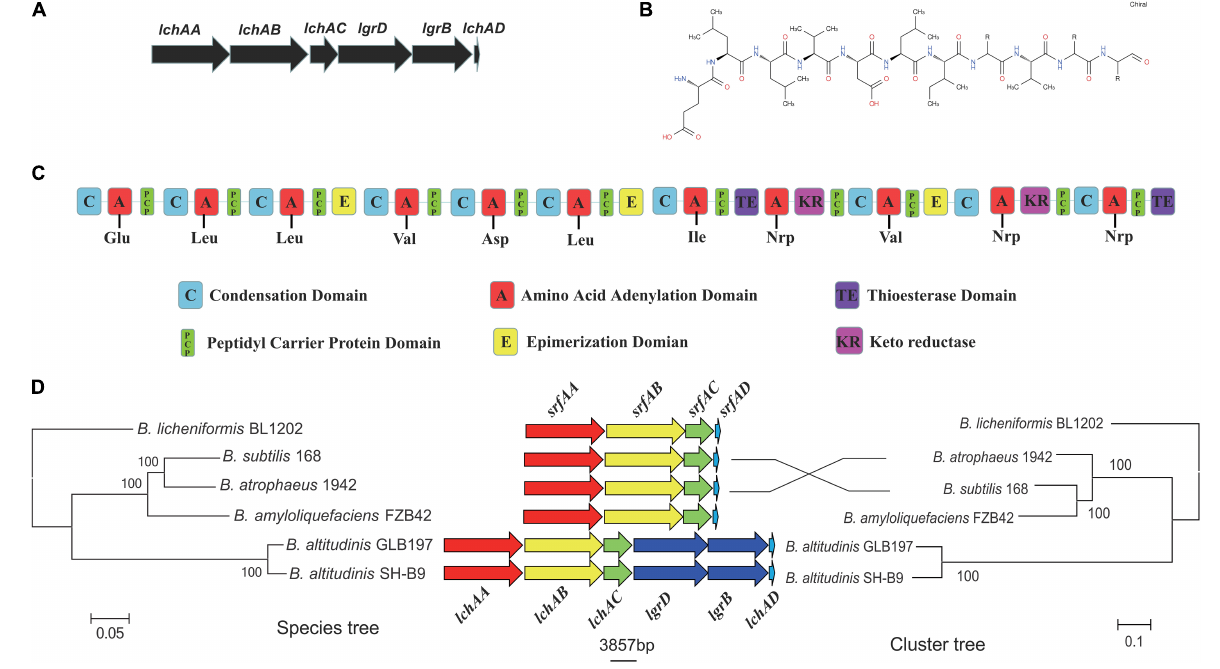
(Manuel Martinez-Garcia et al., 2016). A summary of the genes identified in B. altitudinis GLB197 is provided in Table 2 .